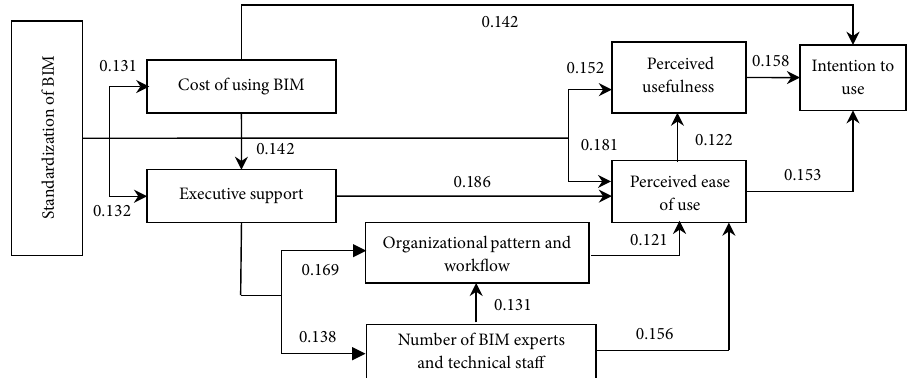
Figure 9. Influence Pathways of Standardization of